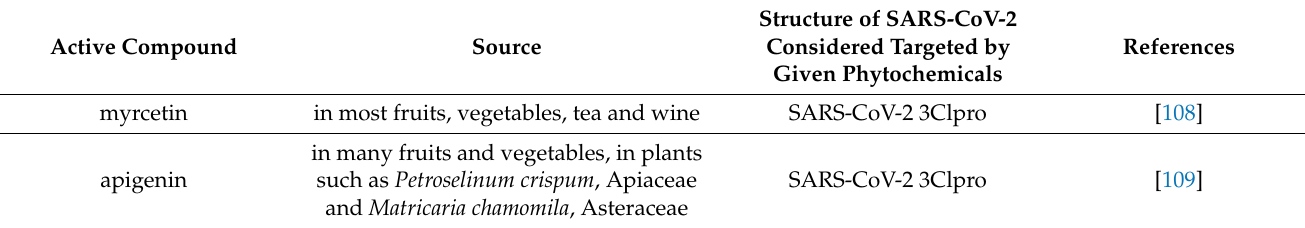
Table 1. Phytochemicals as potential agents against SARS-CoV-2 (proved by molecular docking